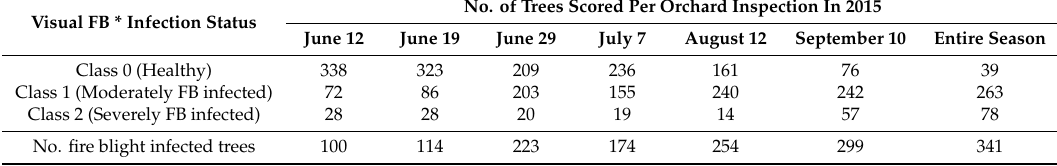
Table 1. Disease incidence and severity scores for 440 trees in a pear orchard cv “Durondeau” at the field inspection dates June 12, June 19, June 29, July 7, August 11, and September 10, 2015. At each observation date the number of healthy trees (class 0), moderately fire blight infected trees (class 1) and severely fire blight infected trees (class 2) were